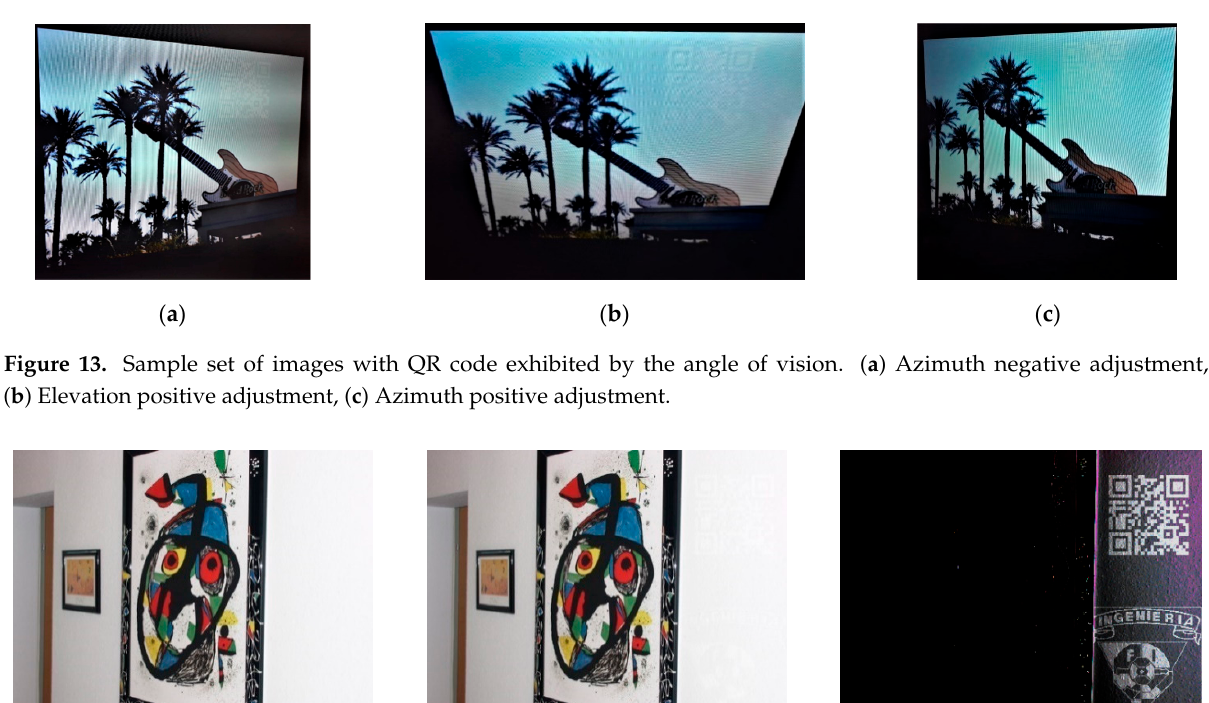
Figure 13. Sample set of images with QR code exhibited by the angle of vision. ( a ) Azimuth negative adjustment, ( b ) Elevation positive adjustment, ( c ) Azimuth positive adjustment.